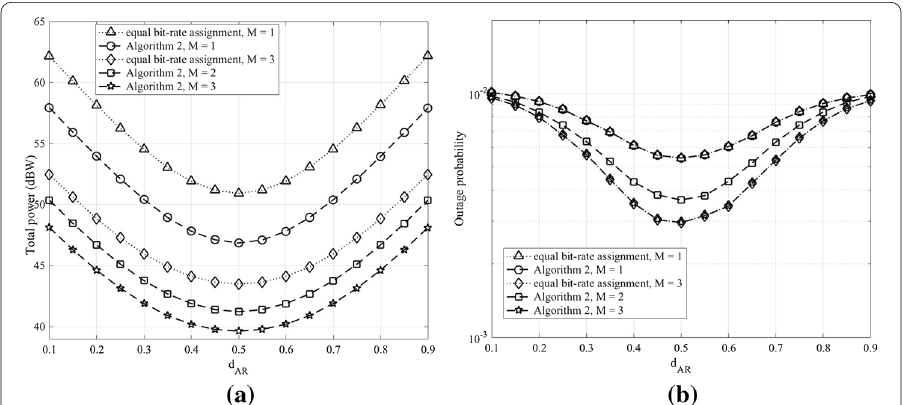
Fig. 2 Total transmit power and outage probability versus d AR , where r = 10bit/s/Hz , K = 16 and Q out = 0.01 .